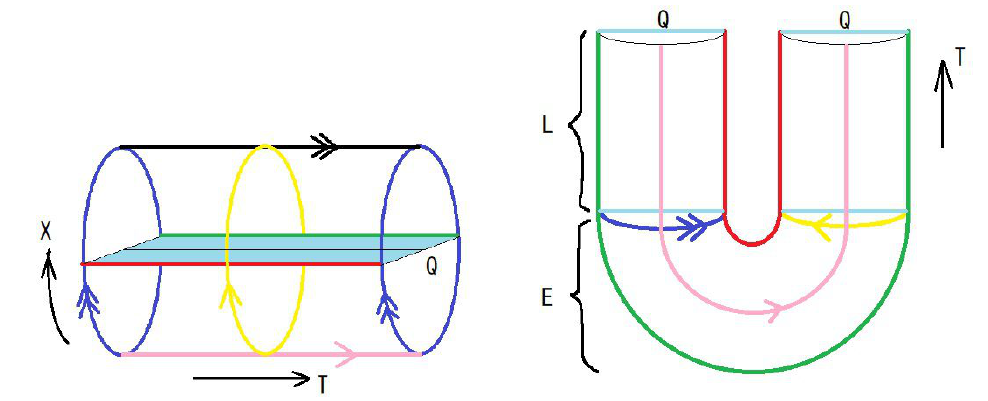
Figure 33 . The picture of the dual geometry in the thermal AdS phase. The left (cid:12)gure describes Euclidean geometry, and the right (cid:12)gure describes Lorentzian time evolution. In this case we impose the dual boundary surface Q has one connected